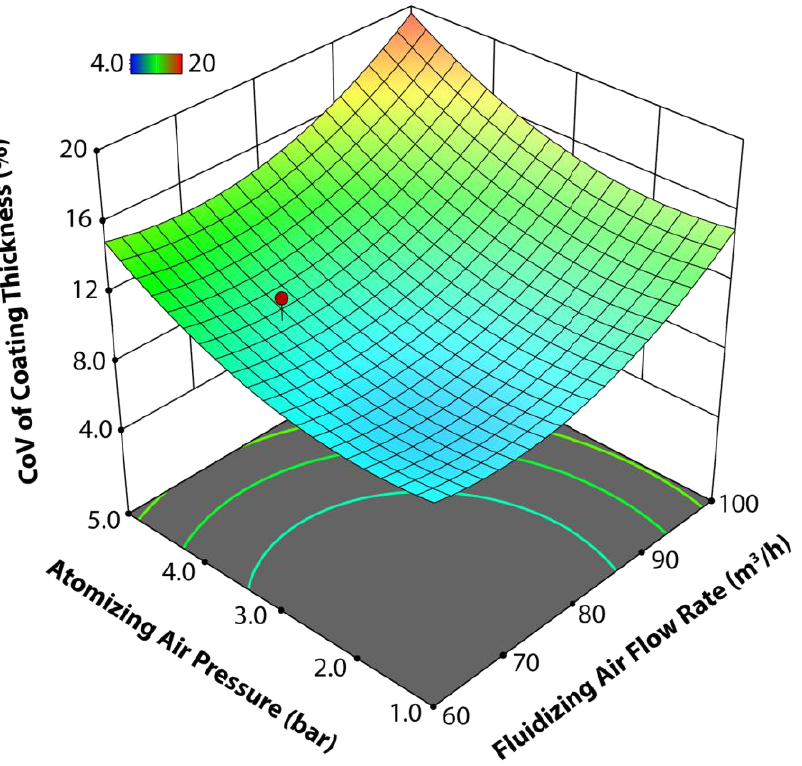
Figure 7. Interactive effect of fluidizing air flow rate ( Q air ) and atomizing air pressure ( P air ) on the CoV of the coating thickness.